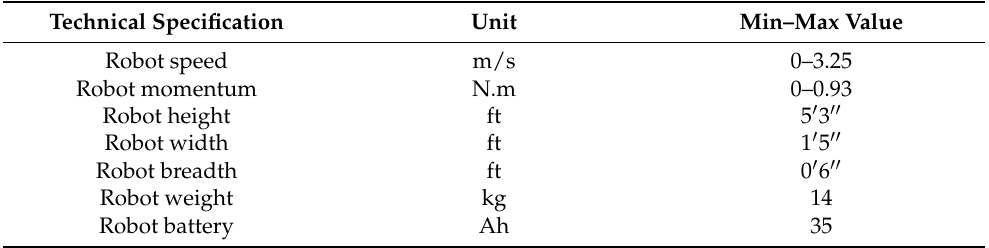
Table 2. Telepresence robot